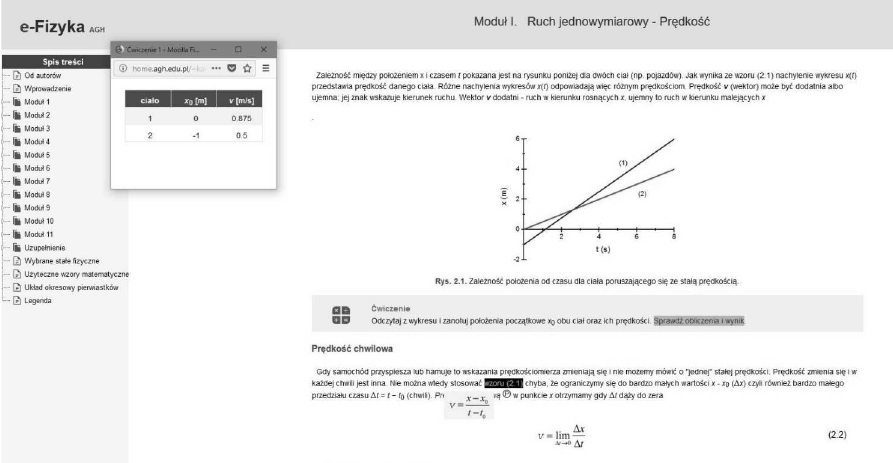
Figure 4. Online interactive textbook with a variety of tasks included on each